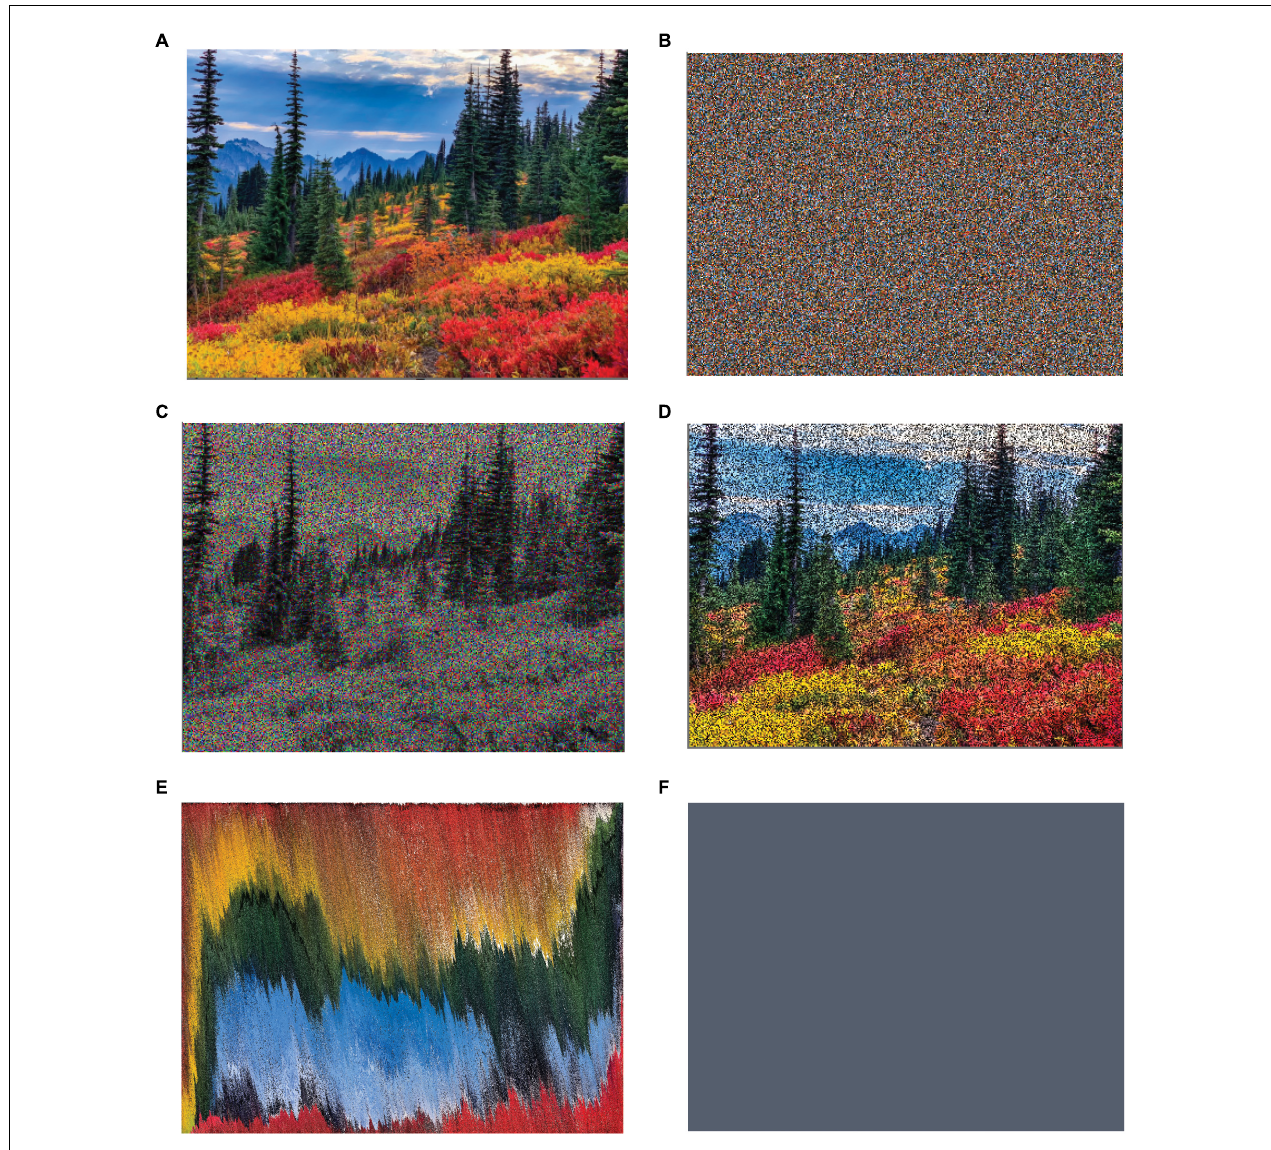
FIGURE 4 | Natural image modified to have too much or too little information. (A) The original image is a of a forest during spring. (B) Image with the Pixels of the Original Scrambled. (C) Image with the Hues of the Original Randomized. (D) Image with the Intensities of the Original Randomized. (E) Image with the Pixels of the Original Moved Near Other Pixels with Similar Color and Intensity. (F) Monochromatic Image with the Mean Color of the Original. Most people like the original image more than versions with too much spatial (A) , chromatic (B) , or intensity (C) complexity (amount of information). Most people like the original image more than versions with too little spatial (E) or generic (B) complexity. These conclusions are statistical and one cannot generalize them to all people. Some people, specially those educated in modern art, may like the images like (C) or (E) more than the original. Images used from Shutterstock royalty-free, by Dmitry Kovba: Washington, USA: Fall colors at Paradise area at Mount Rainier National Park (https://www.shutterstock.com/image-photo/washington-usa-fall-colors-paradise-area-